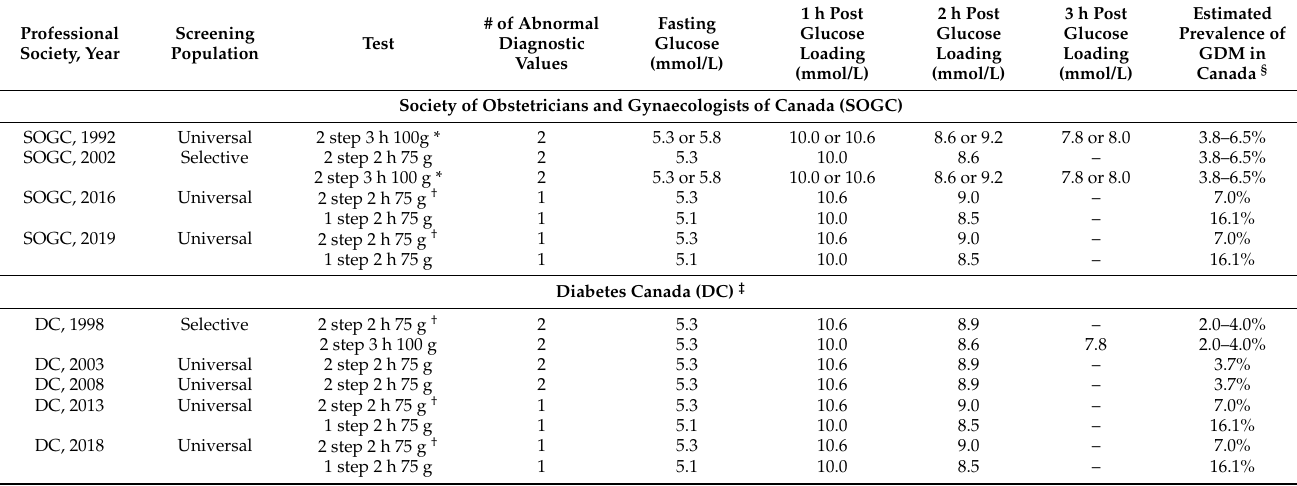
Table 1. Screening and diagnostic criteria for gestational diabetes mellitus